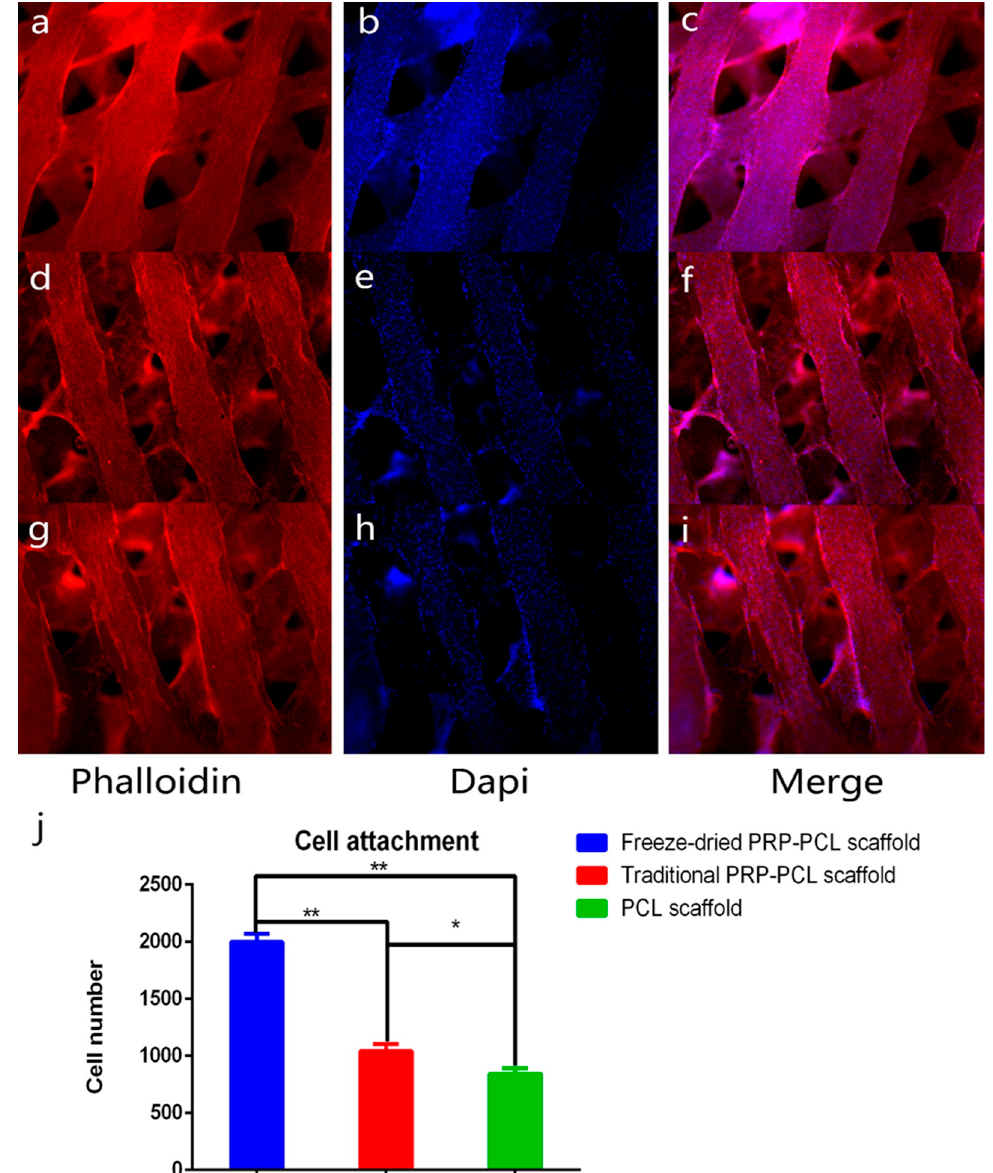
Figure 4. Cell attachment on the freeze-dried PRP-PCL scaffolds ( a – c ); traditional PRP-PCL